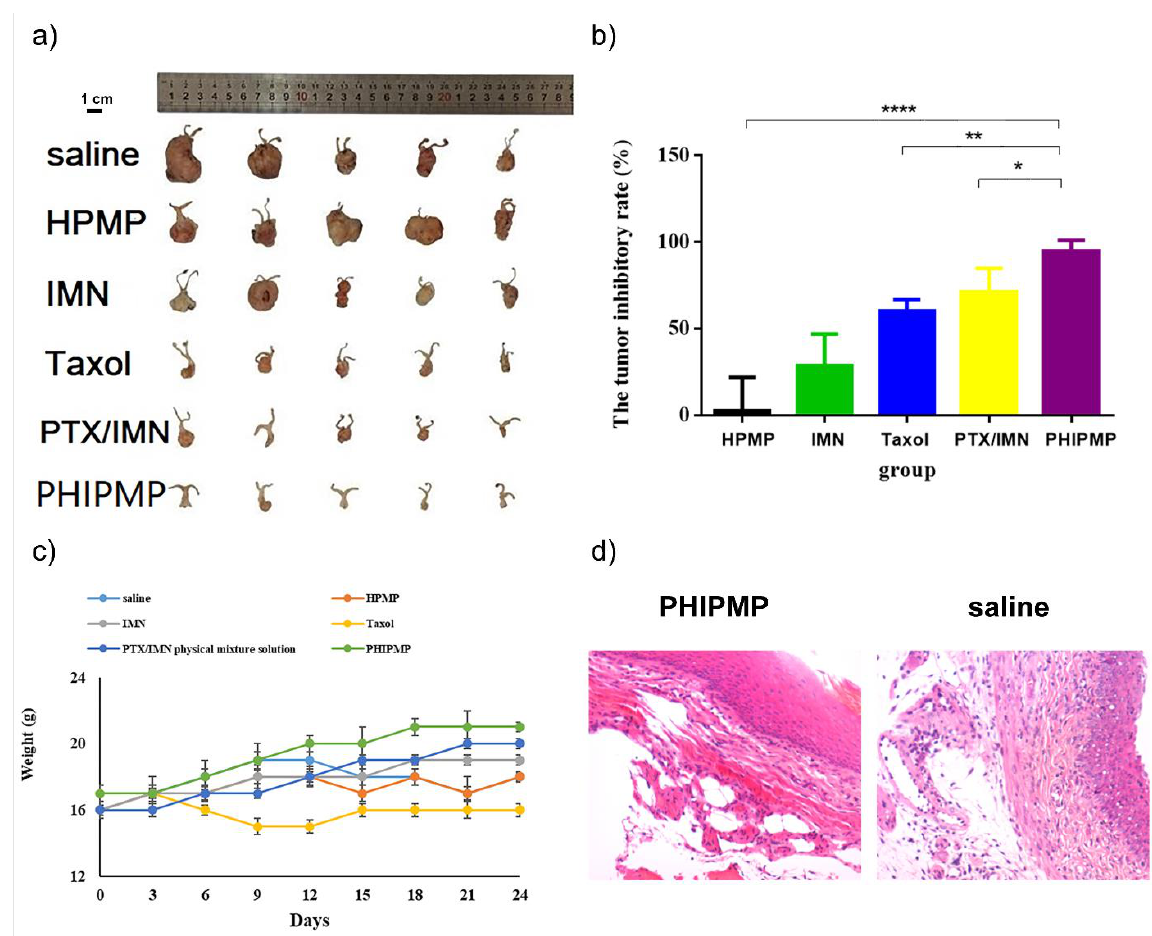
Figure 6. In vivo pharmacological evaluation. ( a ) The tumor size of each group after treatment; ( b ) tumor inhibitory rate ( n = 5); ( c ) body weight change ( n = 5); ( d ) vagina sections stained with H&E. * indicates p < 0.05, ** indicates p < 0.01, **** indicates p < 0.0001. (HPMP: HA/PLGA microparticles; IMN: Imatinib; PTX: Paclitaxel; PHIPMP: PTX/HA-IMN/PLGA microparticles)